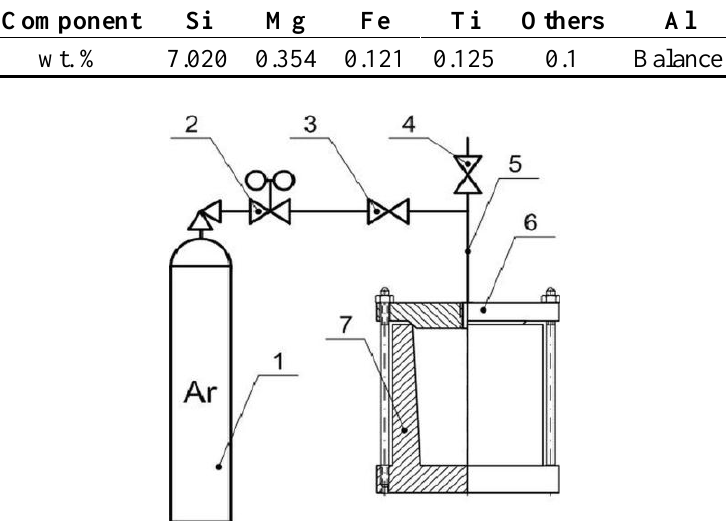
Table 1. Chemical composition of Al-Si A356.